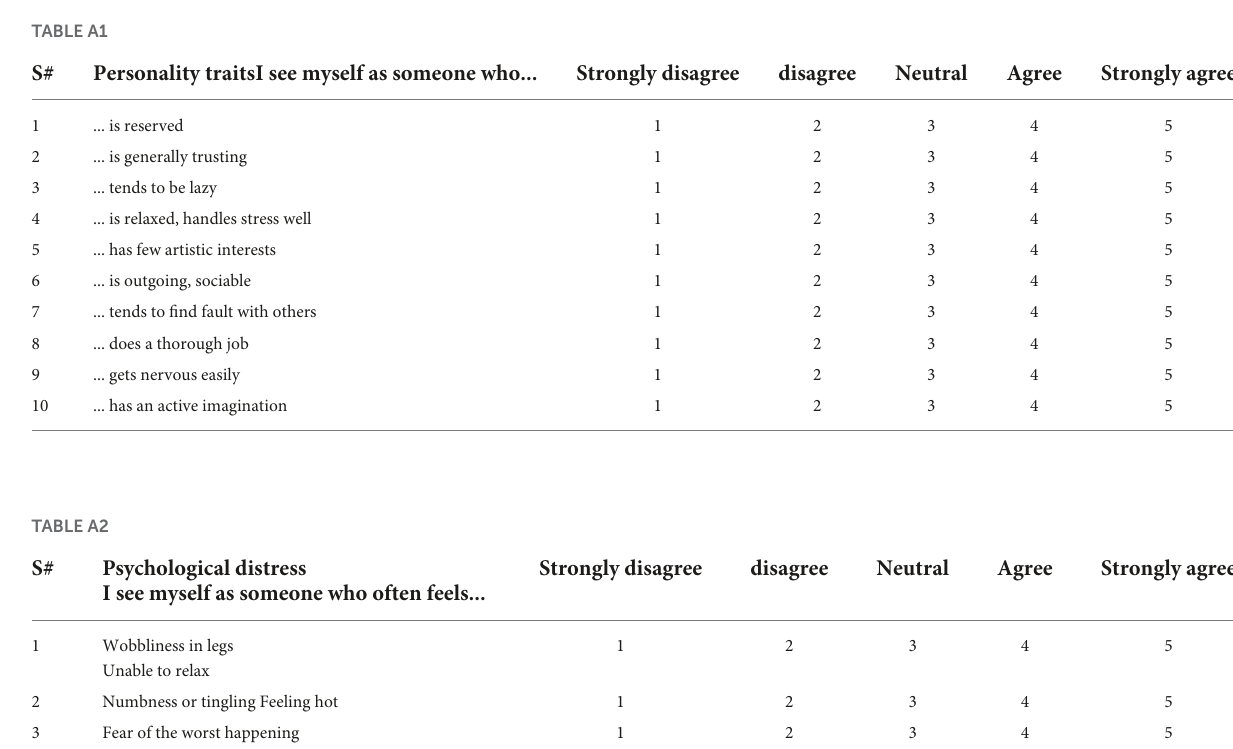
Difficulty in breathing and Fear of